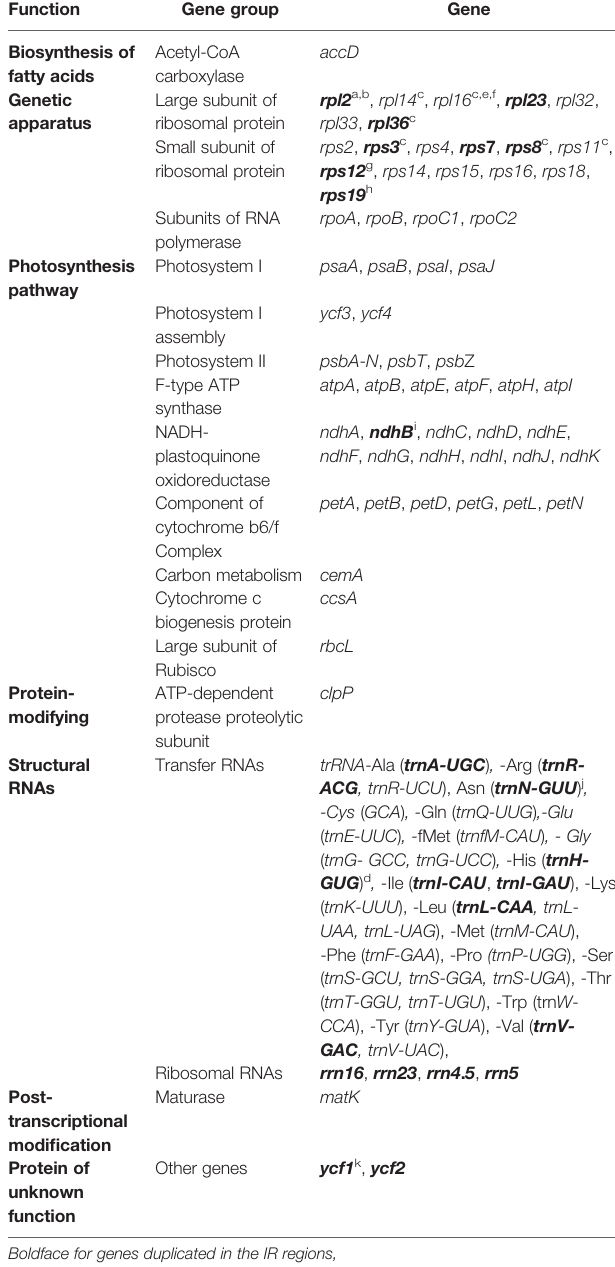
TABLE 1 | Plastome content and their functions in the MP